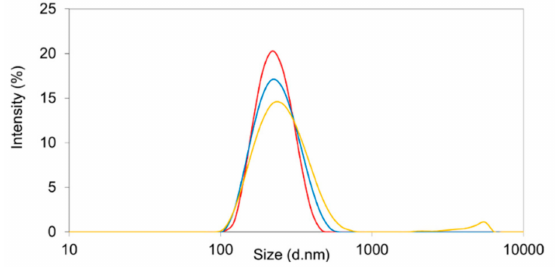
Figure 6. Size distribution by intensity of Resomer ® RGP d5055 nanoparticles after preparation (red line), and following reconstitution after freeze-drying in the presence of 3% of trehalose (blue line) and 3% of mannitol (yellow